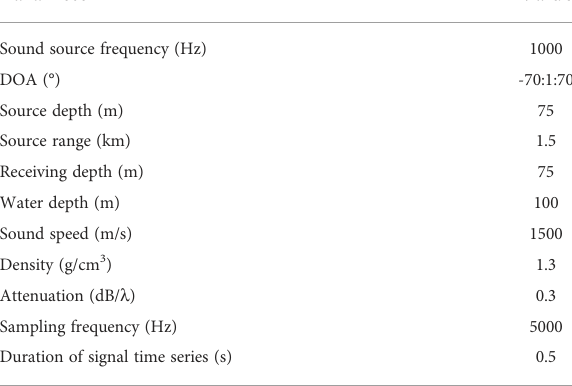
TABLE 1 Environmental parameters of